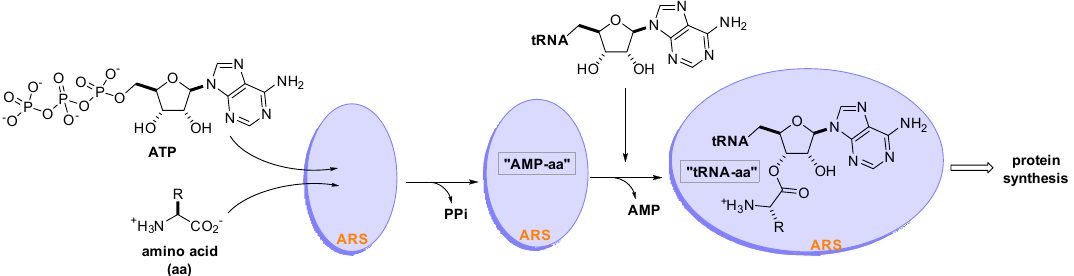
Figure 1. Two-step catalytic reaction of aminoacyl-tRNA synthetases (ARSs). ARSs use an amino acid (aa), ATP, and tRNA as substrates to produce an aminoacylated tRNA (tRNA-aa) that leads to protein synthesis in the ribosome.